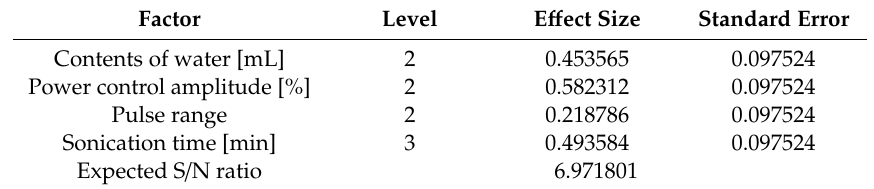
Figure 1. The graphs of average Eta versus input levels of optimized parameters. Solid line—value of Eta, dashed line— ± 2 · standard error, 1,2,3—input levels for each parameters (content of water: 1–350 mL, 2–700 mL, 3–950 mL; power control amplitude 1–20%, 2–60%, 3–100%); pulse range: 1–0.1, 2–0.5, 3–1; sonication time: 1–5 min, 2–20 min, 3–50 min); n = 3. Table 2. Expected S/N ratio (Eta) under optimum conditions.